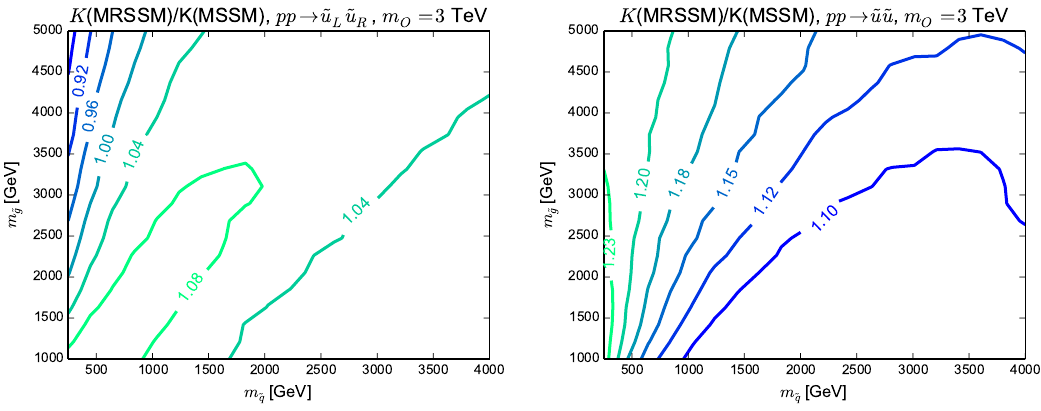
Figure 10. Shown is the ratio of MRSSM over MSSM K-factors for ~ q ~ q production for m O = 3 TeV. In the MSSM, only left-right ~ q ~ q production (left) or all channels (right) are